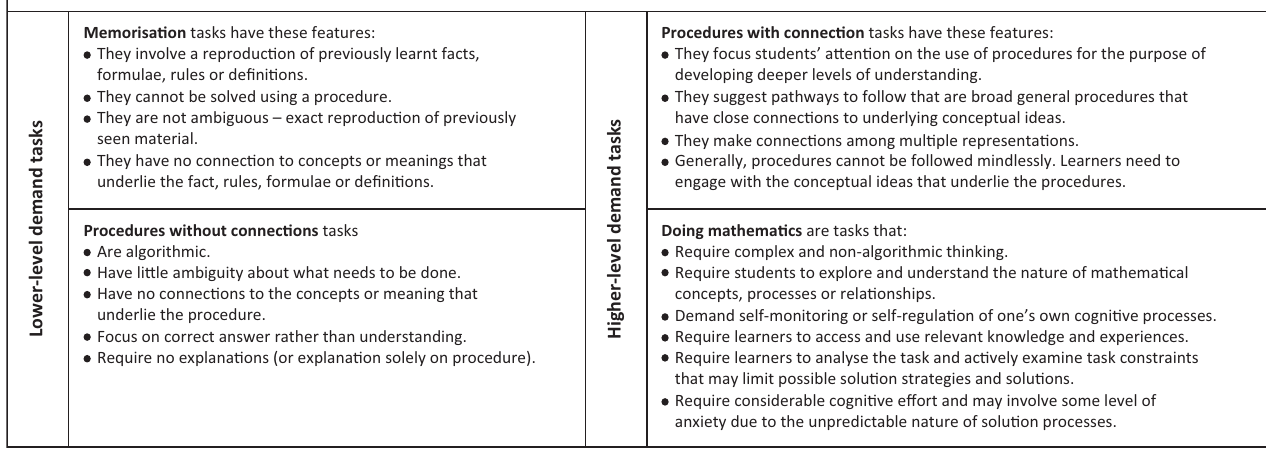
FIGURE 1: A summary of task analysis